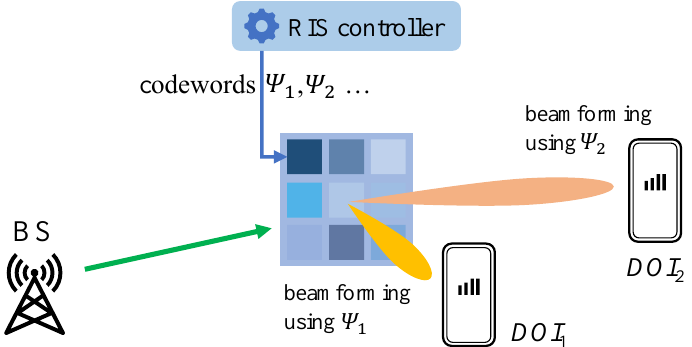
Figure 3. Different beamforming directions given different